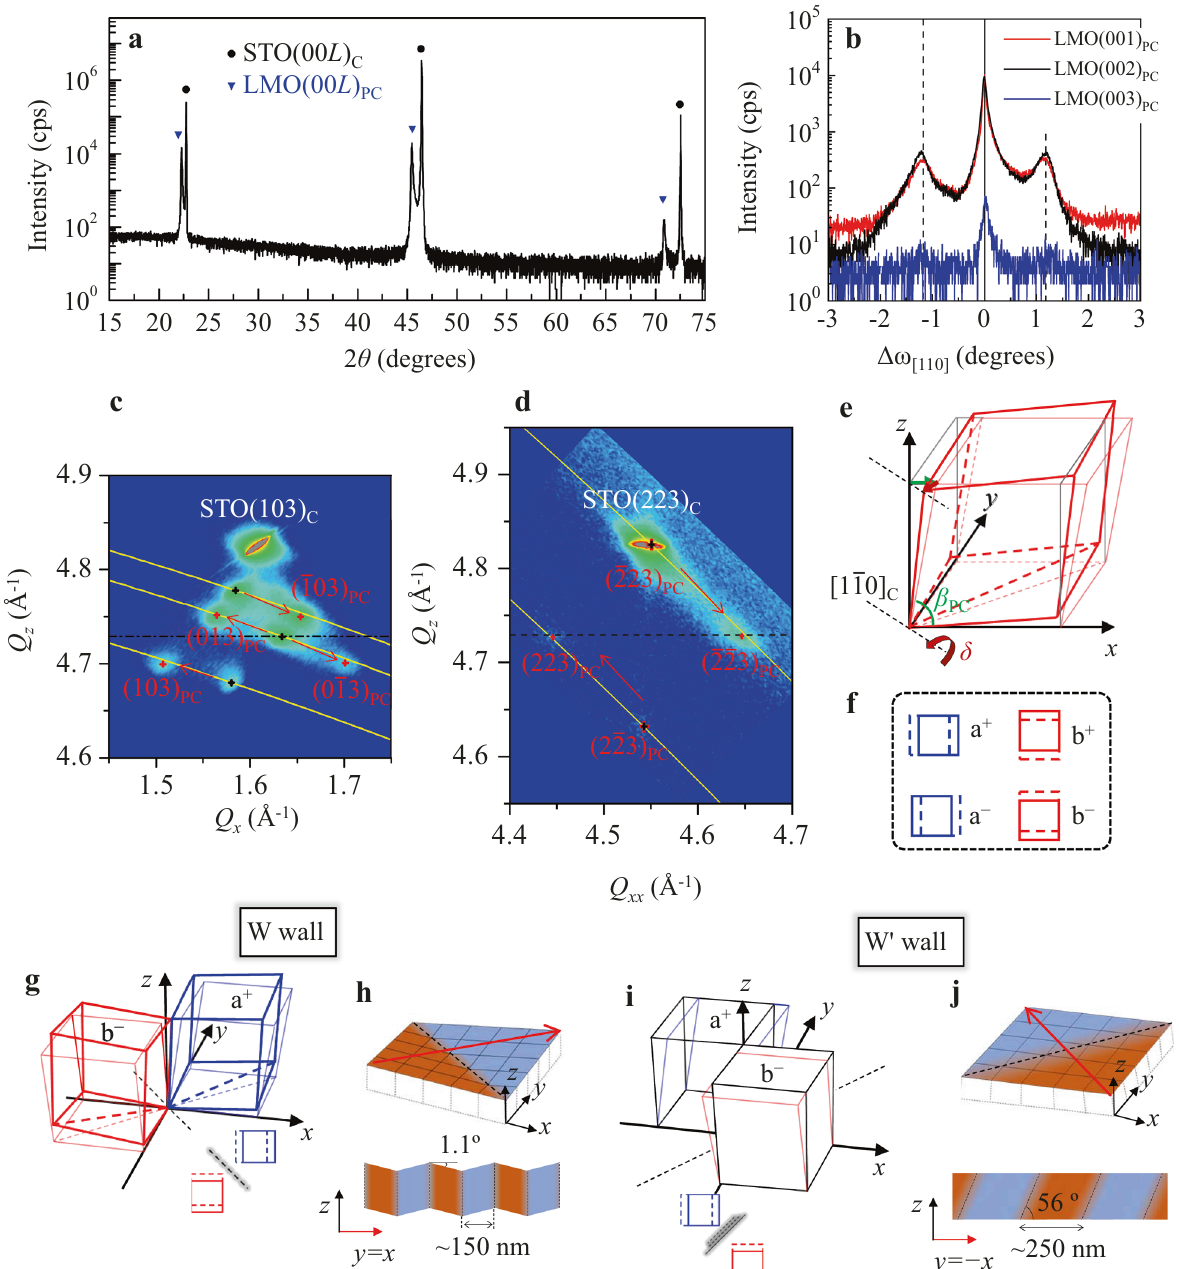
Fig. 6 Structural analysis of the ferroelastic domains. a A conventional θ -2 θ scan along [00 L ] PC including the (001) PC , (002) PC , and (003) PC LMO peaks. b ω -rocking curves measured along the [110] C direction at the LMO (00 L ) PC re fl ections. c RSM for the (103) PC re fl ections. d RSM for the (223) PC re fl ections. The red arrows indicate peak shifts induced by the mosaic rotations. The black (red) dots in RSMs represent the diffraction peak positions of the M c -type monoclinic unit cells without (with) mosaic rotation. e Schematic of a monoclinically distorted pseudocubic unit cell of LMO with (thick red) and without (pale red) mosaic rotation by δ . f Four possible variants of the monoclinic tilts. A solid (dashed) border indicates the top (bottom) surfaces of the unit cells. g A con fi guration of a + and b − unit cells with cooperative mosaic rotations and the top view. h The schematic of the a + /b − domains with an W wall. i A con fi guration of the unit cells without mosaic rotation and the top view. j The schematic of the fl at a + /b − domains with an W ’ wall. The black dashed lines in g – j represent domain walls. The cross- sectional schematics (bottom) in h , j correspond to line pro fi les along red solid